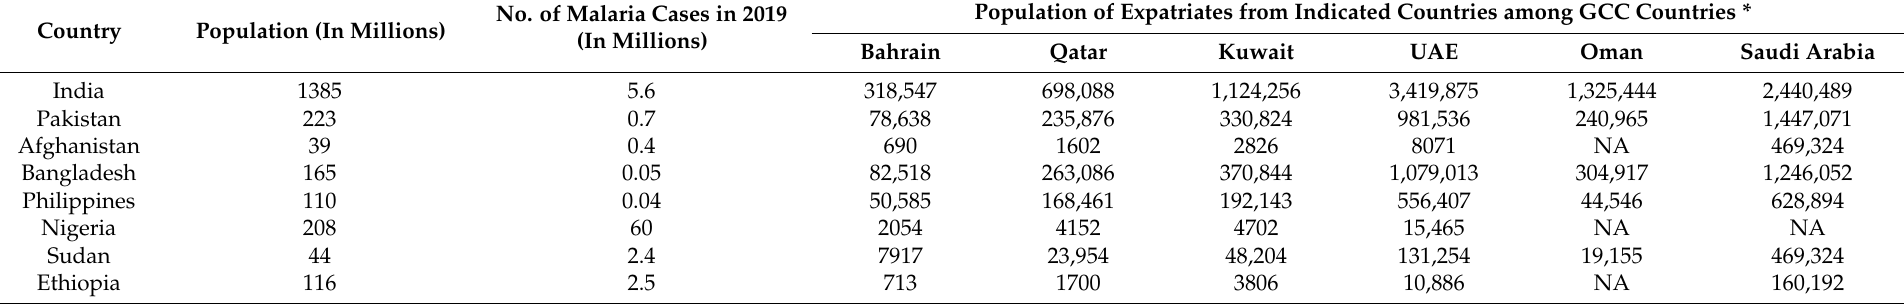
Table 2. No. of malaria cases reported by WHO in 2019 from some malaria endemic countries whose nationals predominate as expatriate workers in GCC countries.